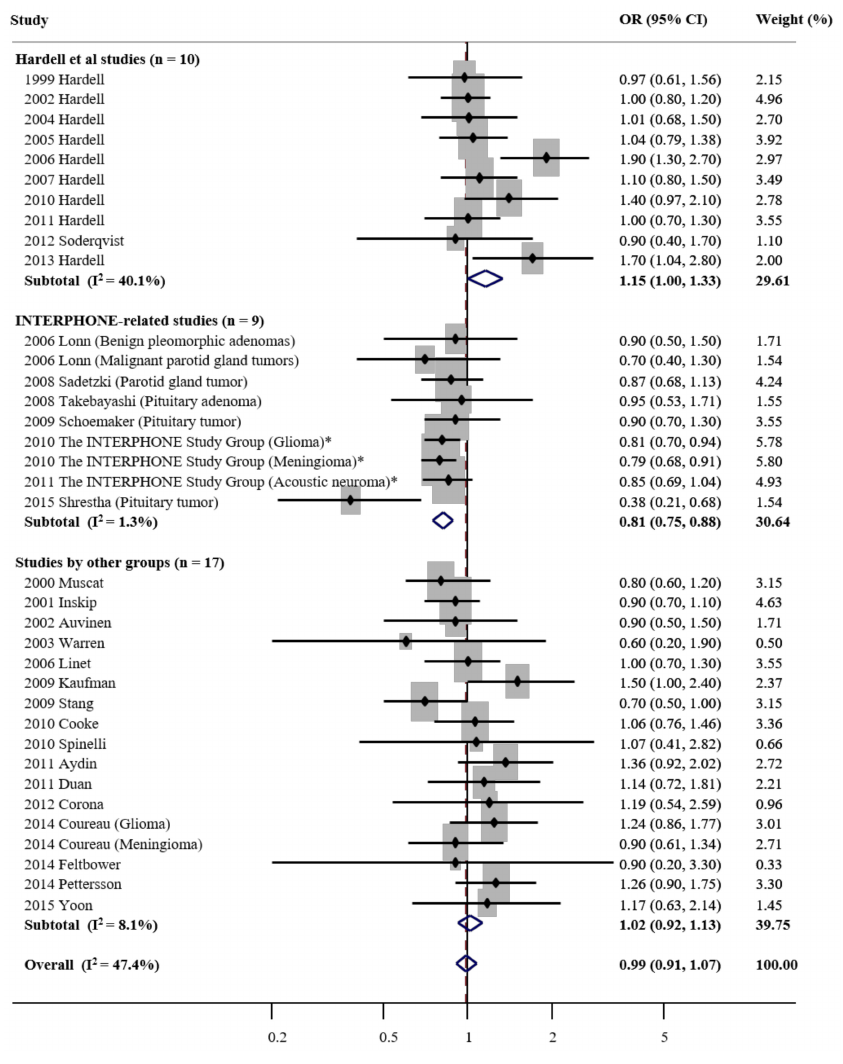
Figure 2. Cellular phone use and risk of tumors in a random-e ff ects subgroup meta-analysis of case-control studies by research groups ( n = 36). OR—odds ratio; CI—confidence interval. *—2010 and 2011 The INTERPHONE Study Group studies involved 13